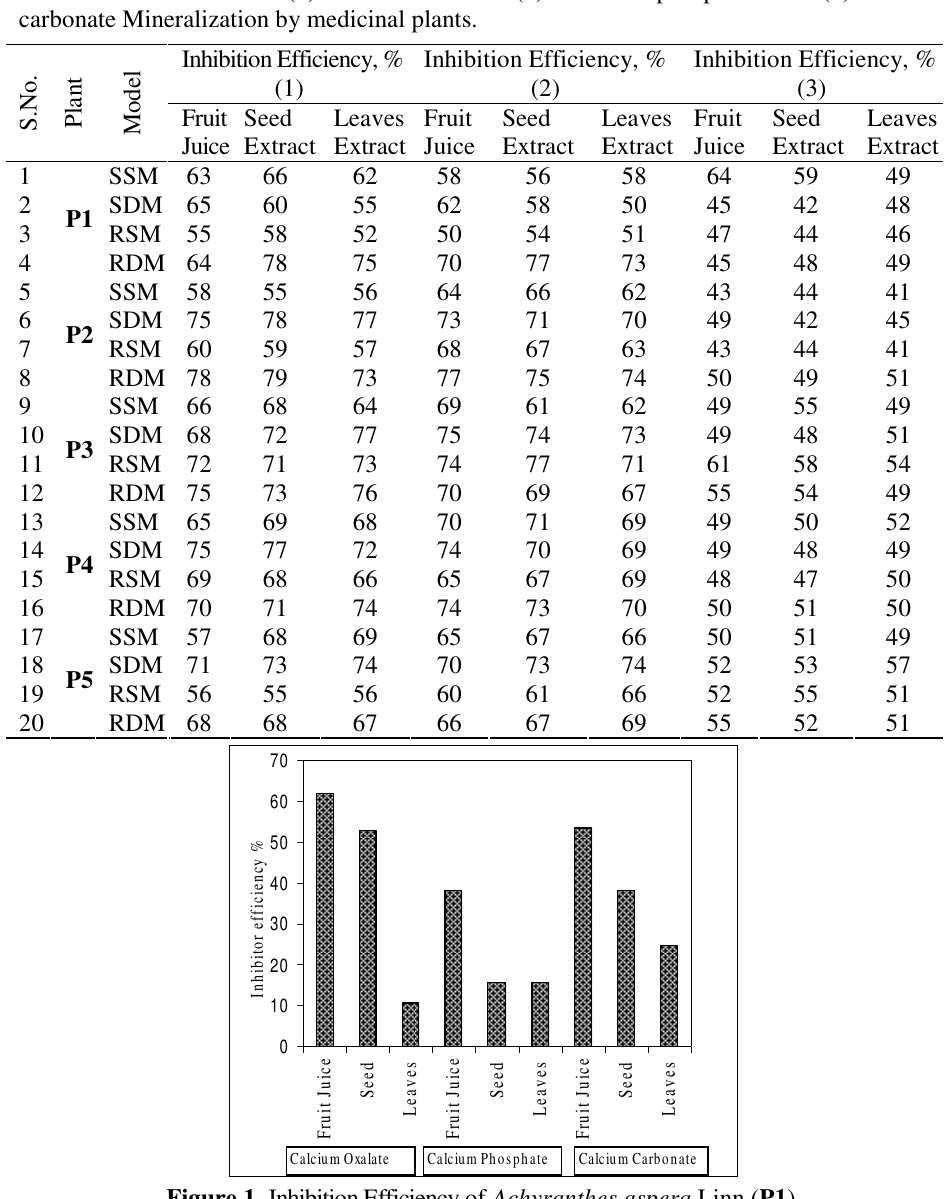
Figure 1 . Inhibition Efficiency of Achyranthes aspera Linn ( P1